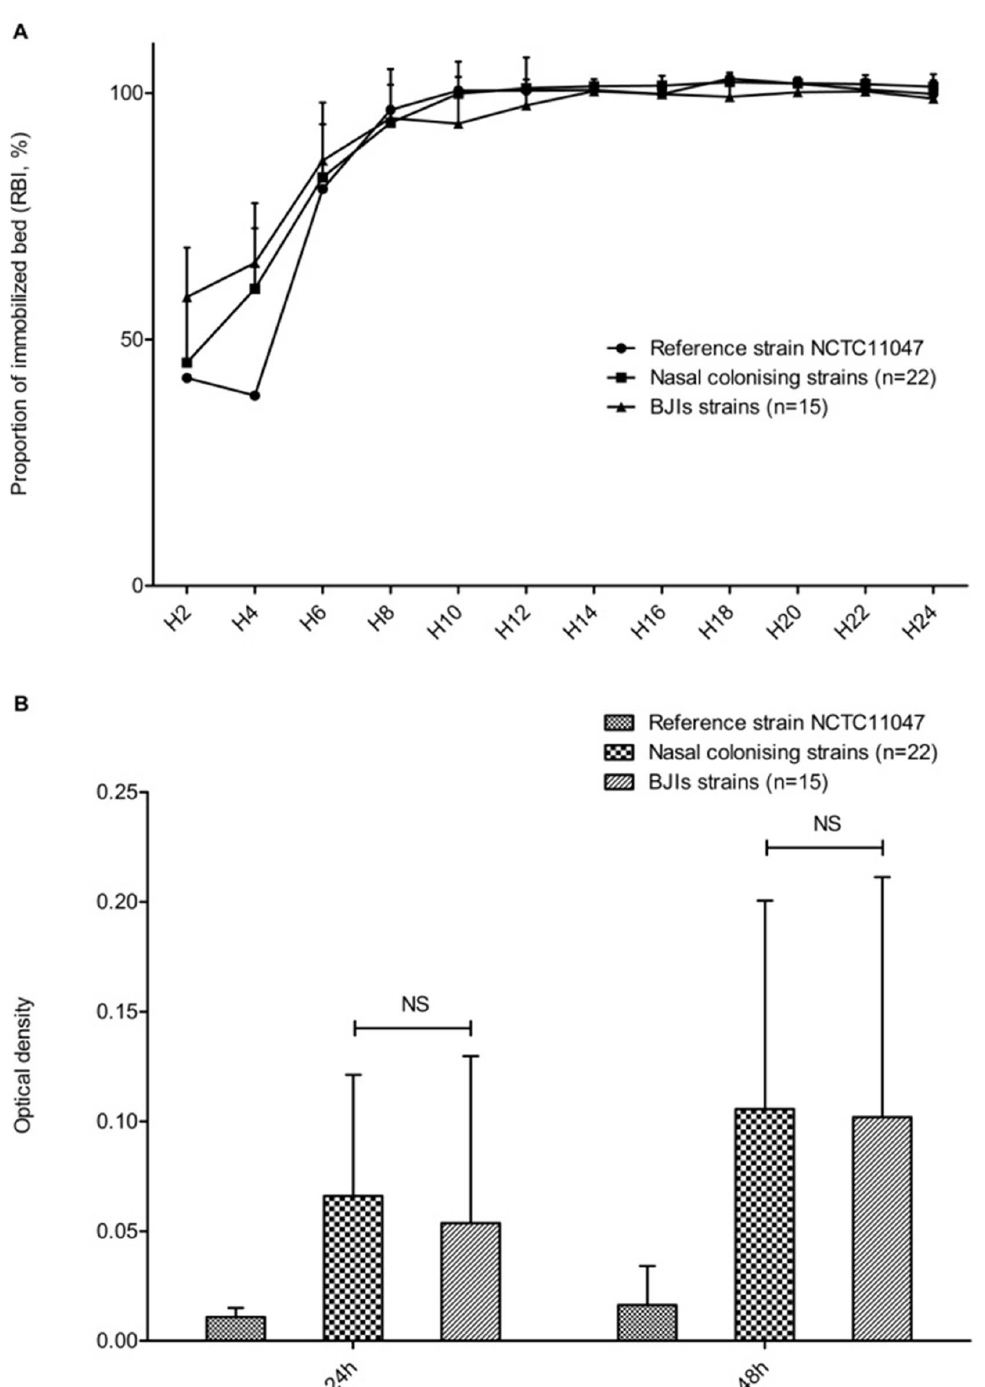
Figure 4. Quantification of S.epidermidis adhesion to MG63 osteoblasts. After 2 h of co-culture of MG63 osteoblasts with infective and colonizing S. epidermidis strains (n=3 each) and S. aureus strains at an MOI of 500:1 and 100:1, respectively, adhered bacteria were labeled using the membrane-impermeable fluorochrome BODIPY FL vancomycin. The results are presented as the means and standard deviations of the proportion of cells bearing bacteria (A) and of arbitrary fluorescence units (AFUs) (B).